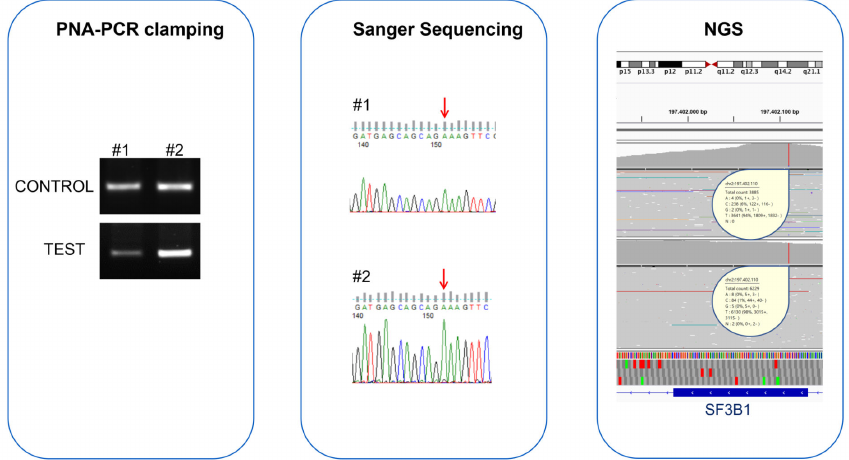
Figure 3. Comparison of PNA-PCR clamping, Sanger sequencing, and NGS for the evaluation of SF3B1 status in two MDS patients with contrasting results. The electrophoretic runs of PNA-PCR clamping, carried out in the absence (CONTROL) and presence (TEST) of the PNA probe, showed amplification in both the samples, indicating the presence of the SF3B1 p.Lys700Glu mutation in these patients. In contrast, Sanger sequencing chromatograms showed the presence of only one allele (red arrows); the nucleotide “A” indicates that both patients were WT for SF3B1 p.Lys700Glu mutation. NGS confirmed the PNA-PCR clamping result, indicating that these samples contained SF3B1 p.Lys700Glu with mutation percentages of 1.3% and 6.1%, respectively. Both samples had mutation percentages lower than the Sanger sequencing LoD, but they were detected by PNA-PCR clamping